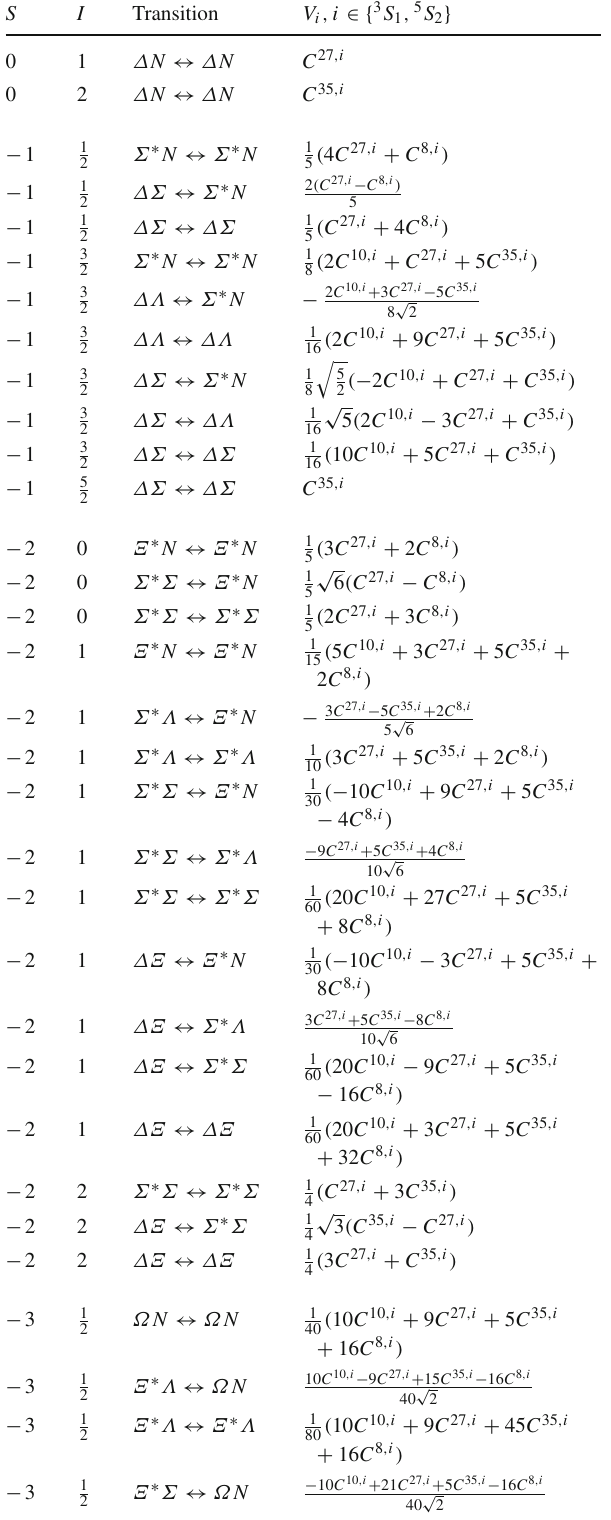
Table 9 SU(3) relations of DB → DB in non-vanishing partial waves. The subscript { 11 } of the constants C r omitted in the table